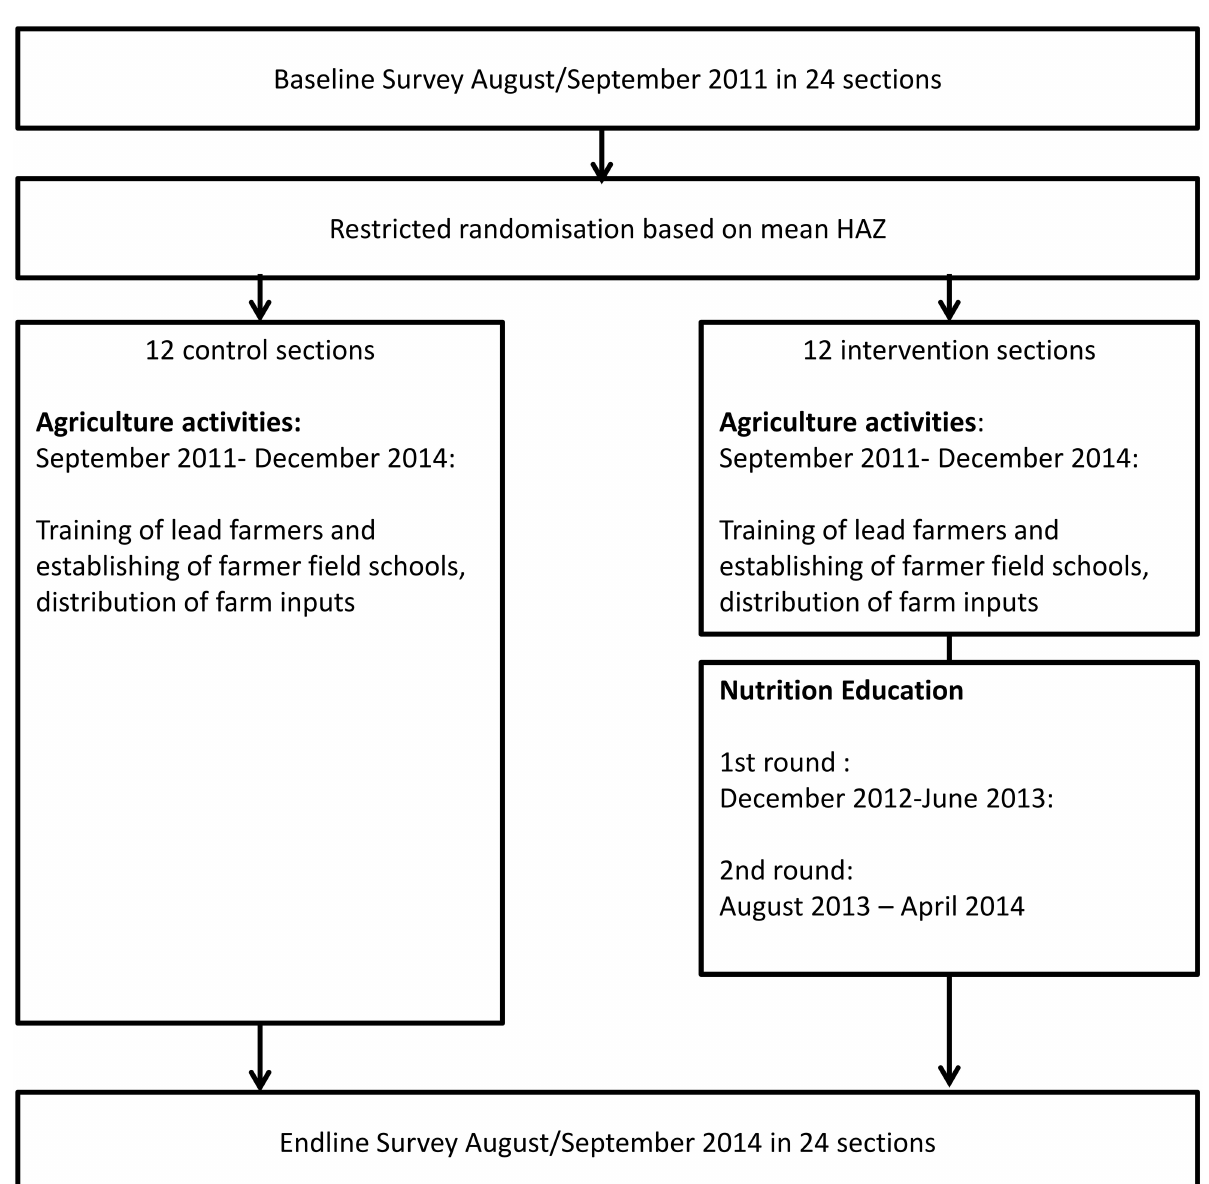
Fig 3. Flow-diagram of trial design. After a cross-sectional baselinesurvey in August/September 2011, the project area was dividedin control and intervention area based on mean HAZ. From September 2011 –December 2014the control area receivedagriculturalactivities only, whilethe intervention area received agricultural activitiesas well as two rounds of NE in the same time period. A cross-sectional endlinesurvey was conductedin August/September